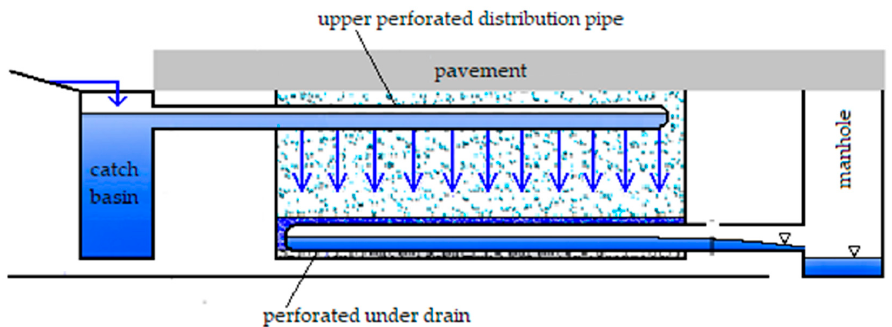
Figure 1. An underground RBR without a surface layer.